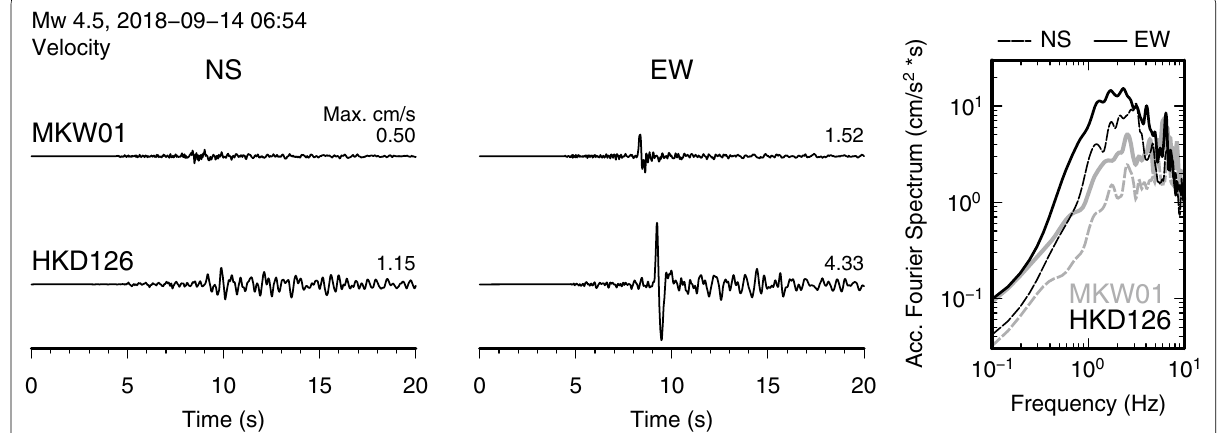
Fig. 7 Horizontal ground velocities and acceleration Fourier spectra at two stations in Mukawa town for the M w 4.5 earthquake (Event 1: September 14, 2018). The velocity waveforms (left and center) were derived from the acceleration records. The strong motion stations (HKD126 and MKW01) and the epicenter of Event 1 are shown in Fig. 1. The right panel shows their acceleration spectra